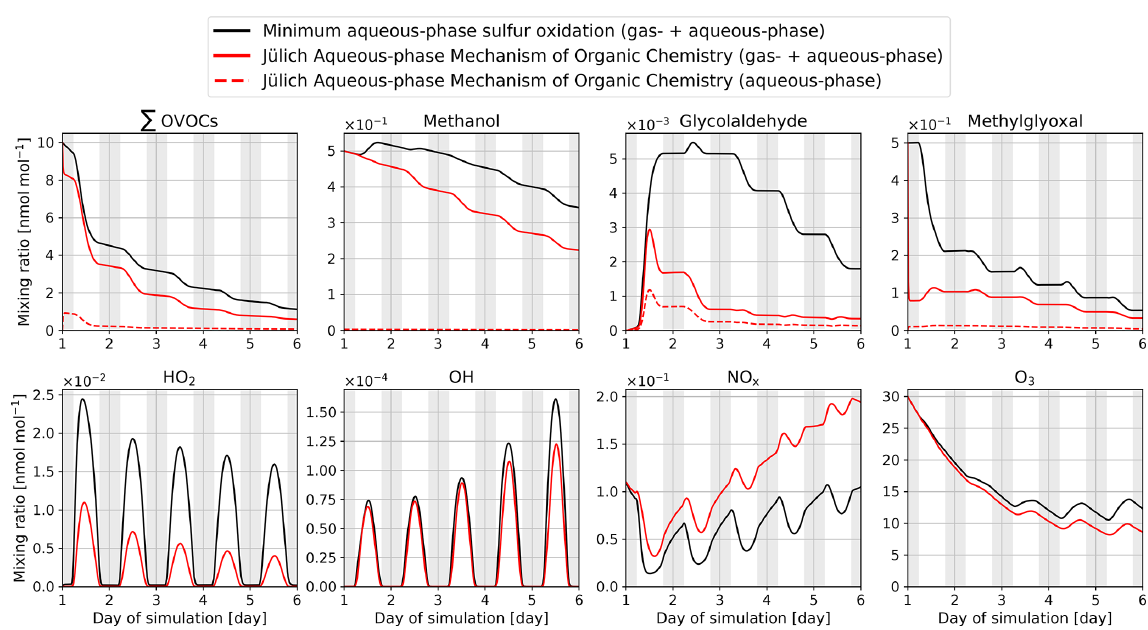
Figure 3. Time evolution for total mixing ratios (gas + aqueous phase) of the sum of all the OVOCs explicitly oxidised in the proposed mechanism ( (cid:80) OVOCs; see Eq. A1 in Appendix A), methanol, glycolaldehyde, methylglyoxal, HO 2 , OH, NO x , and O 3 within the box model CAABA. Mixing ratios are provided for two cases, one using the minimum aqueous-phase mechanism in global models (sulfur oxidation only, black line) and the other using JAMOC (red line). In addition, aqueous-phase mixing ratios of (cid:80) OVOCs, methanol, glycolaldehyde, and methylglyoxal are given for the simulation using JAMOC. The aqueous-phase mixing ratios include the gem-diols formed for the species listed in Table 1. Nighttime is indicated by grey background shading. Note that lines may